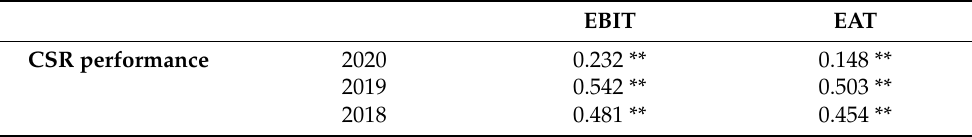
Table 4. Correlation analysis (CSR level vs. corporate